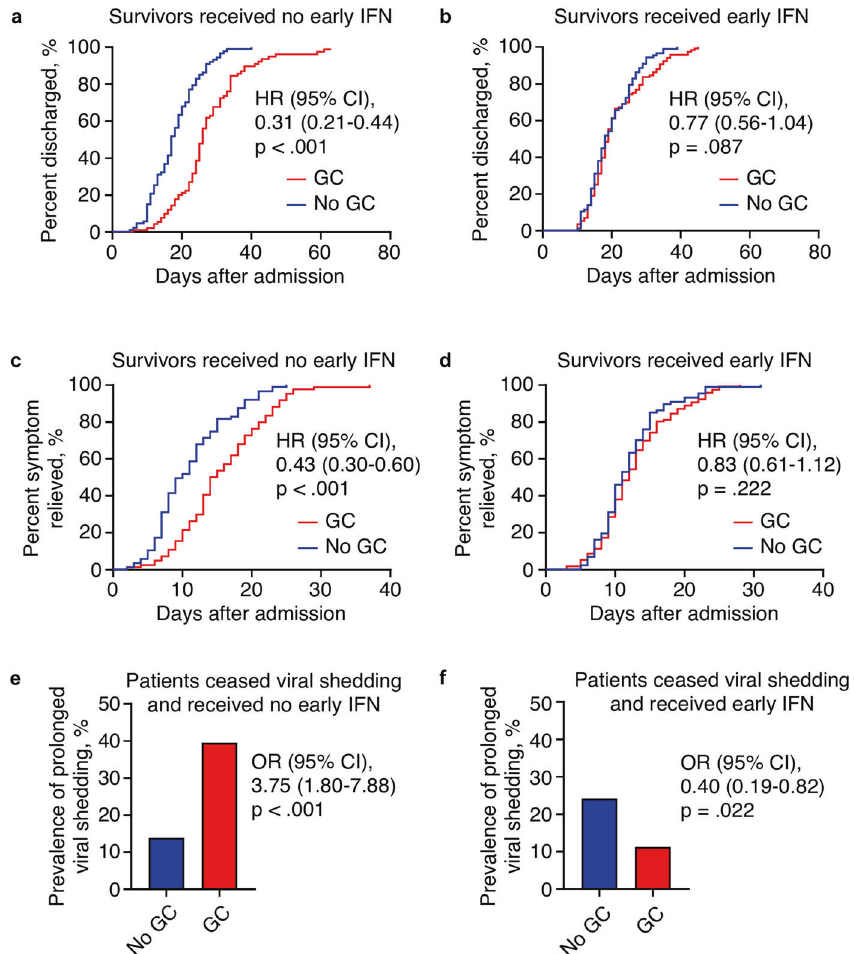
Fig. 2 Association of early IFN therapy with reduced GC adverse effects on COVID-19 recovery. a , b Cumulative incidence curves for hospital discharge among survivors without ( a ) or with early IFN therapy ( b ). n = 84 (GC) and 87 (no GC) for a ; 116 (GC) and 87 (no GC) for b . c , d Cumulative incidence curves for symptom relief among survivors without ( c ) or with early IFN therapy ( d ). n = 84 (GC) and 87 (no GC) for c ; 116 (GC) and 87 (no GC) for d . e , f Bar graph of PVS prevalence among patients ceased viral shedding before discharge and without ( e ) or with early IFN therapy ( f ). n = 88 (GC) and 87 (no GC) for e ; 116 (GC) and 87 (no GC) for f